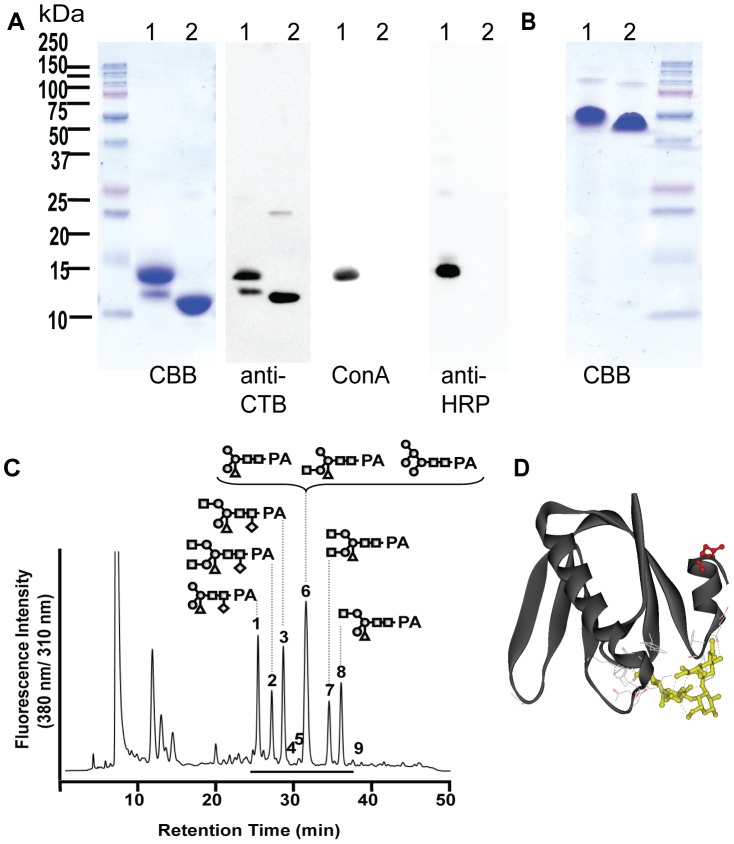
Transgenic N. benthamiana-expressed CTB is N-glycosylated.
A, denaturing SDS-PAGE (Coomassie Brilliant Blue Stained, CBB) and an anti-CTB immunoblot showed that transgenic plant-expressed CTB has two monomer species, whereas the E. coli-produced counterpart has only one. The lectin concanavalin A (ConA) and anti-peroxidase antibodies (Anti-HRP) both bound to the upper band of the plant-expressed CTB, but not to the lower band or the eCTB, demonstrating the presence (in the upper band) and absence (lower band) of plant N-glycans in the plant-expressed B subunit (Lane 1 – CTB purified from transgenic Nicotiana benthamiana; 2 – eCTB) B, non-heat denaturing SDS-PAGE showed that transgenic Nicotiana-expressed CTB and the E. coli-made counterpart were assembled into homo-pentamers. The lane numbers are the same as in Fig. 1A
. C, analysis of N-glycan structure showing the presence of plant-specific α(1, 3)-fucose/β(1,2)-xylose-containing glycans. The chromatogram shows RP-HPLC separation of 2-aminopyridine (PA)-labeled glycans isolated from Nicotiana-expressed CTB, with representative glycan structures depicted at corresponding PA-glycan fractions. A horizontal line represents the elution position for PA-labeled glycans. Symbols: circle (○), mannose; square (□), N-acetylglucosamine; diamond (◊), fucose; and triangle (Δ), xylose. D, a crystal structure image showing a CTB monomer complexed with GM1-ganglioside (side view; PBD ID: 3CHB). Dot lines in green represent hydrogen bonds involved in binding to GM1-ganglioside, which is shown in yellow. Asn4, which is glycosylated upon expression in eukaryotic cells, is highlighted in red. It is evident that the Asn4 side chain does not interact with GM1-ganglioside. Image was created in Accelrys Discovery Studio Visualizer 2.5.